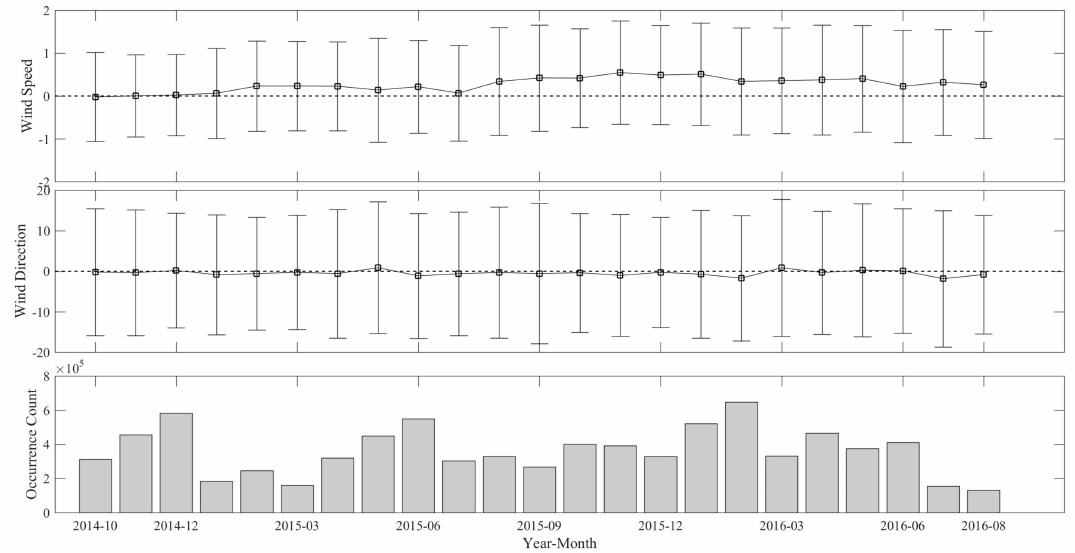
Figure 10. statistical parameters of difference between RapidScat and ASCAT wind vectors in different months from October 2014 to August